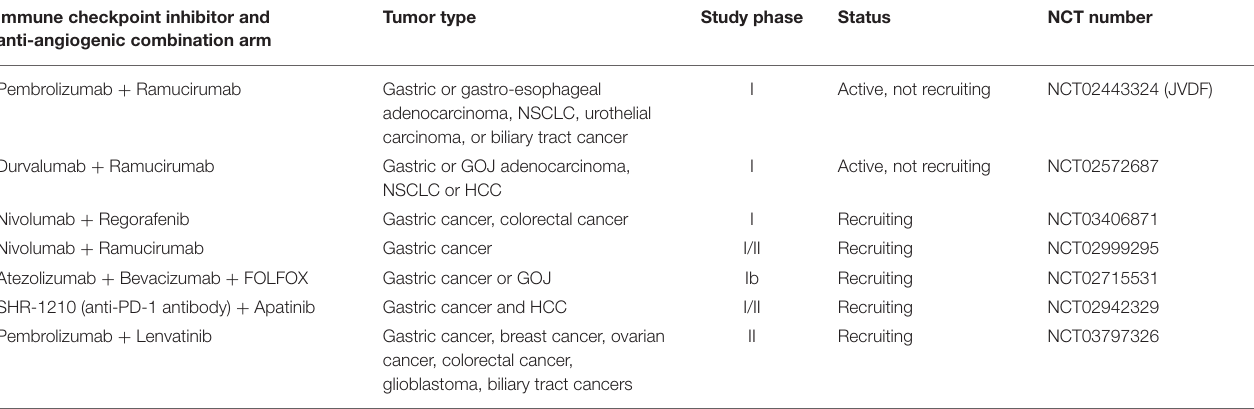
TABLE 6 | Selected clinical trials investigating immune-checkpoint inhibitors combined with anti-angiogenic therapy in OG cancer. Immune checkpoint inhibitor and anti-angiogenic combination